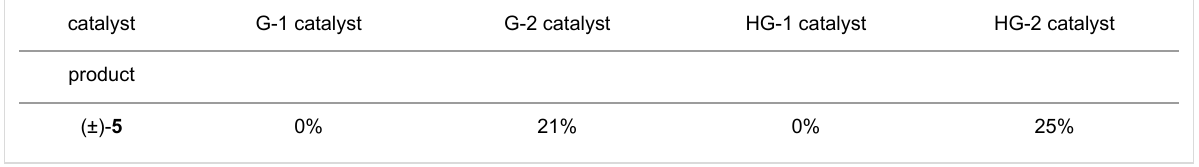
Table 1: Isolated yields for compound (±)- 5 formed in the ring-opening reaction of lactone (±)- 3 with ethylene in ROM reactions with various catalysts.